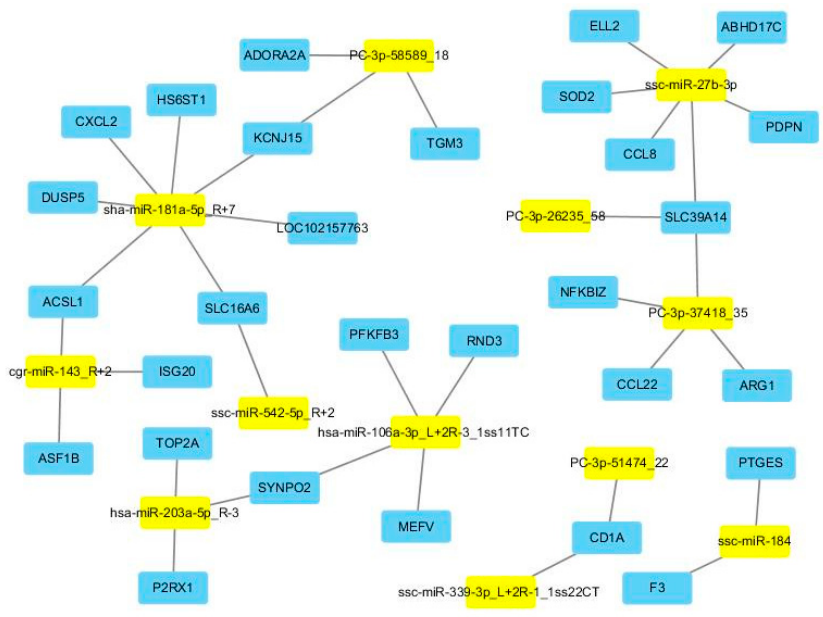
Figure 4. Regulation network between DE miRNAs and their DE target genes in response to poly I:C stimulation. Yellow and blue colors mean miRNAs and target genes, respectively.